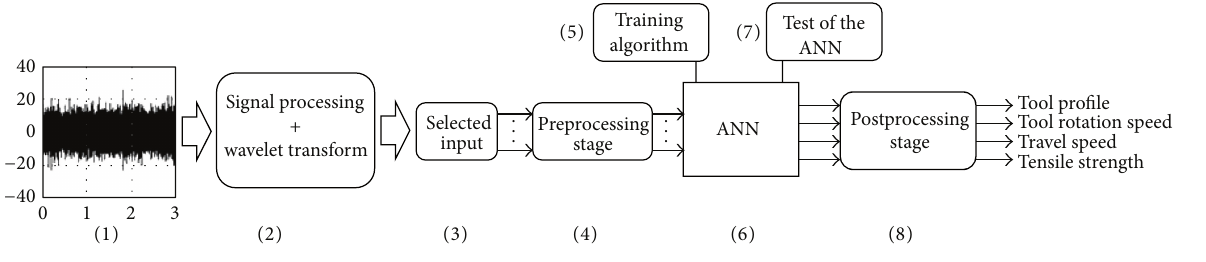
Figure 2: Methodology of ANN development.